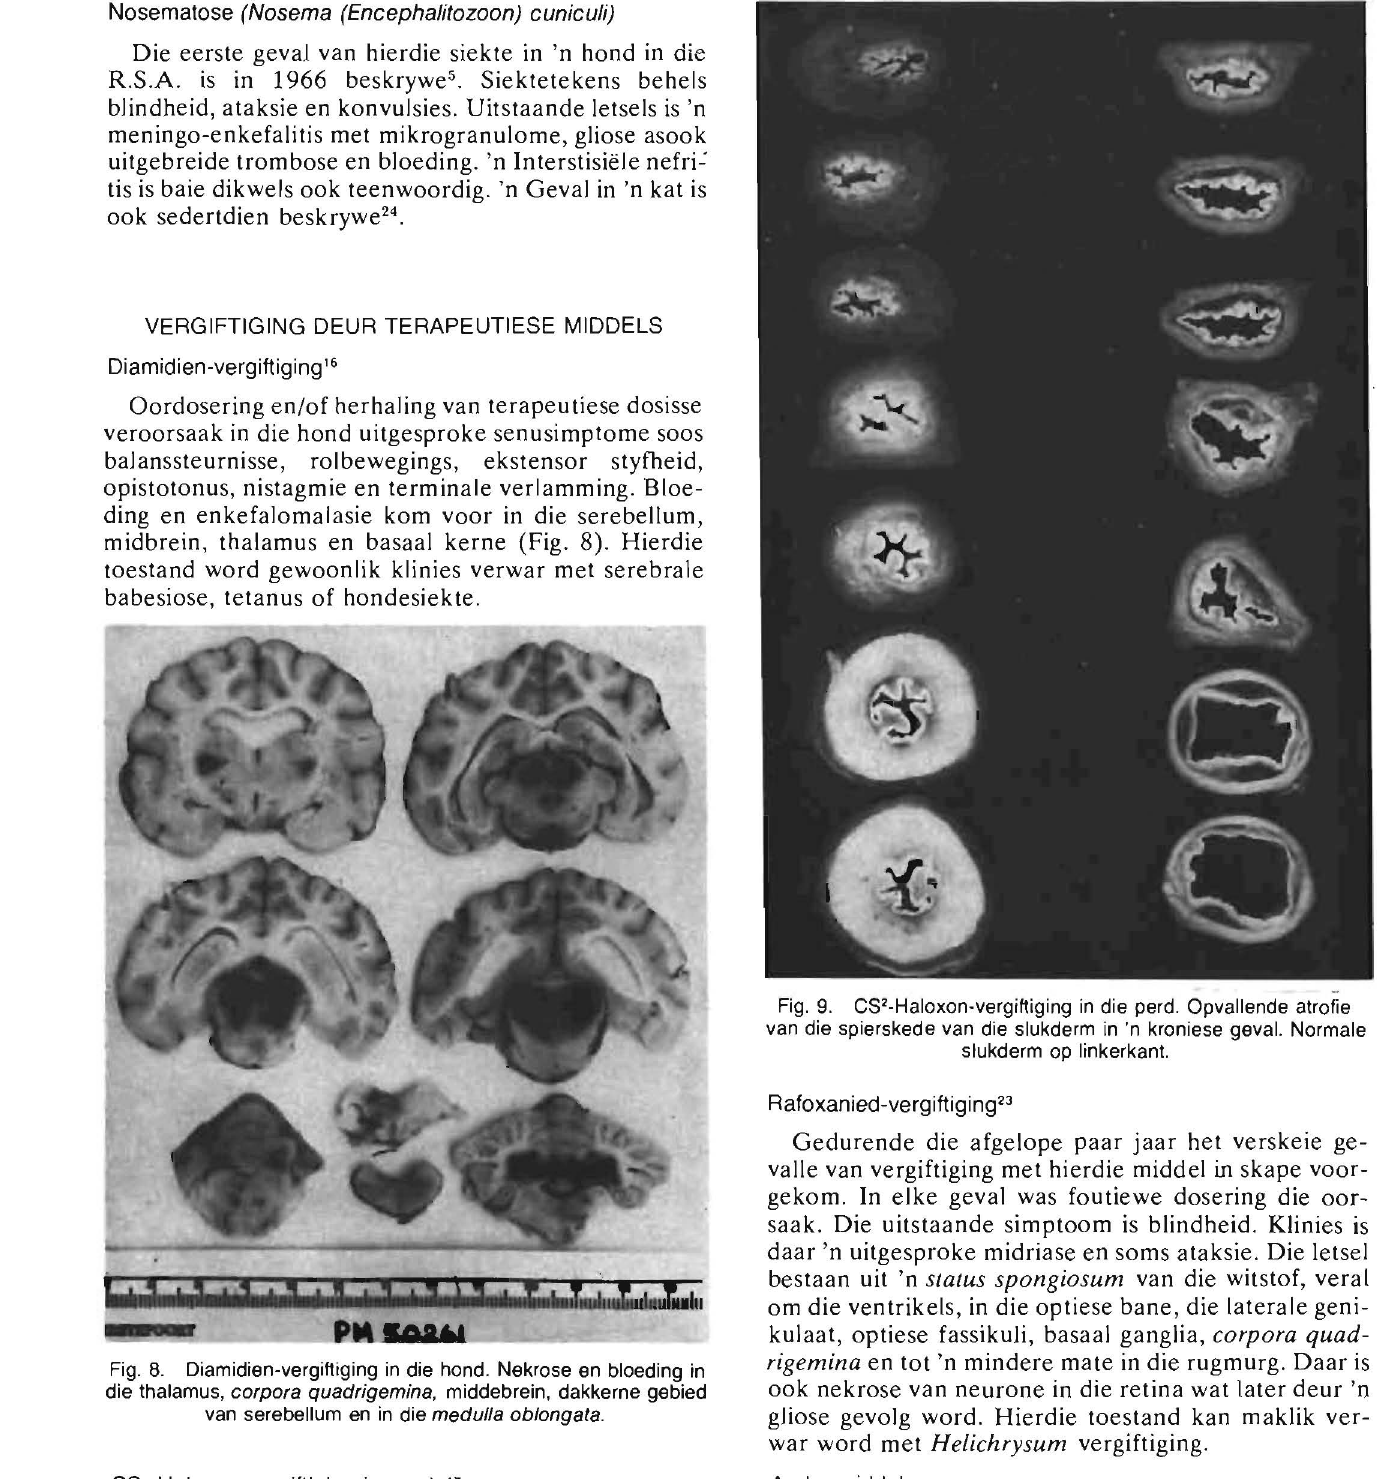
Fig. 8. Diamidien-vergiftiging in die hond. Nekrose en bloeding in die thalamus, corpora quadrigemina, middebrein, dakkerne gebied van serebellum en in die medulla oblongata.